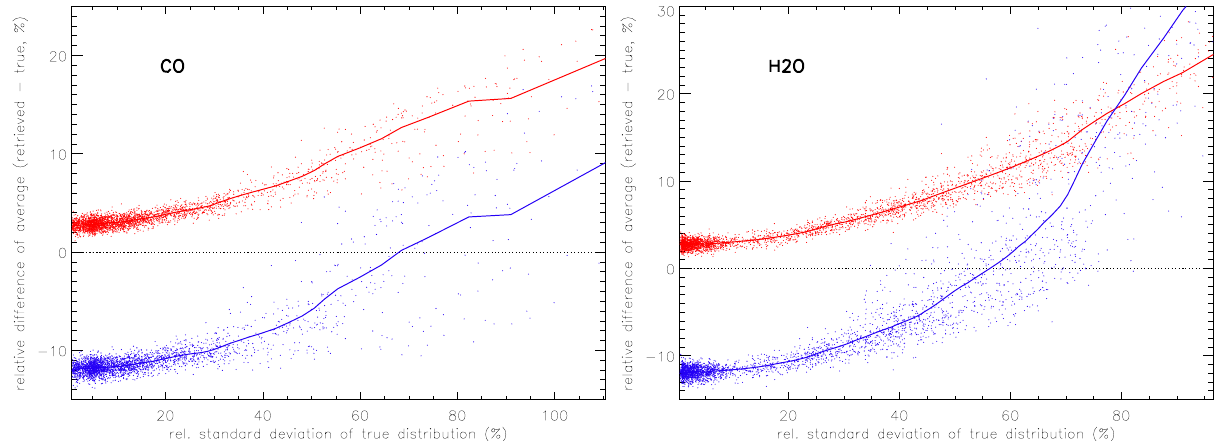
Fig. 4. Differences of retrieved and “true” zonal means (relative to the latter) versus local natural variability in terms of standard deviation for CO (left) and H 2 O (right). Red: linear averages, blue: logarithmic averages. Data points reflect individual latitude/altitude boxes. Results are shown for maximum likelihood ln(vmr)-retrieval simulations with a signal to noise ratio of